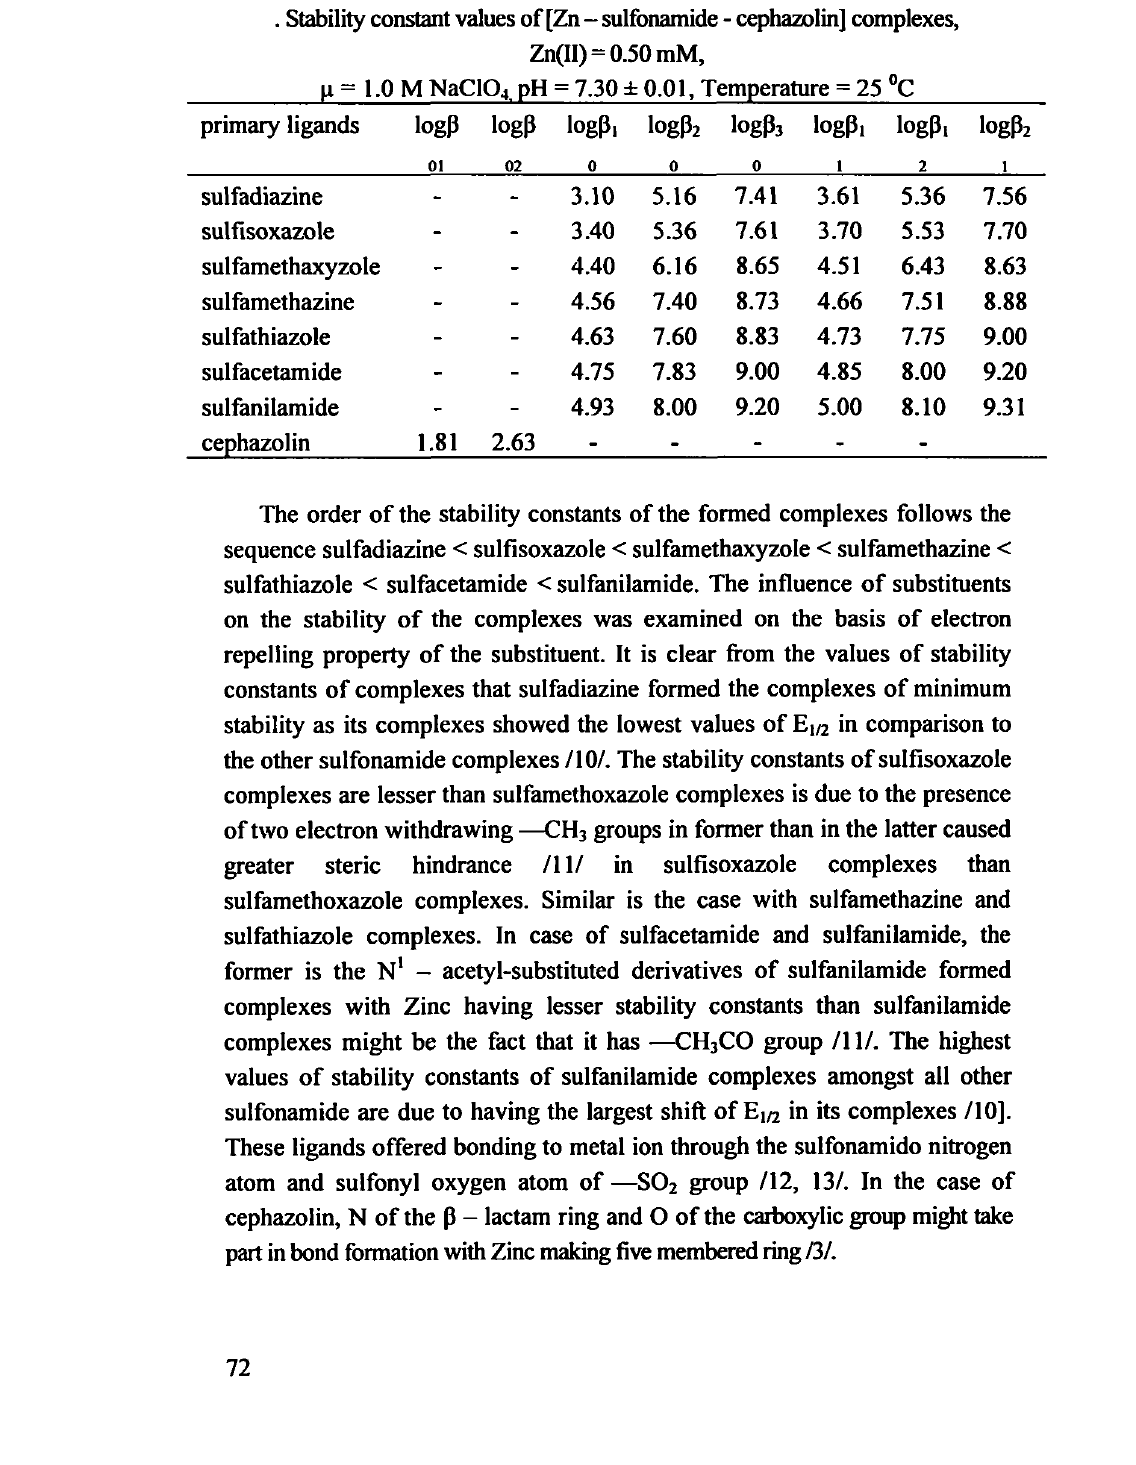
. Stability constant values of [Zn - sulfonamide - cephazolin]